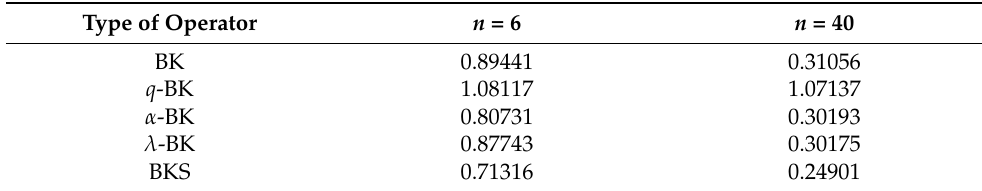
Table 1. Maximum absolute error of approximation for the function 𝐷(cid:3553)(𝑡) Type of Operator